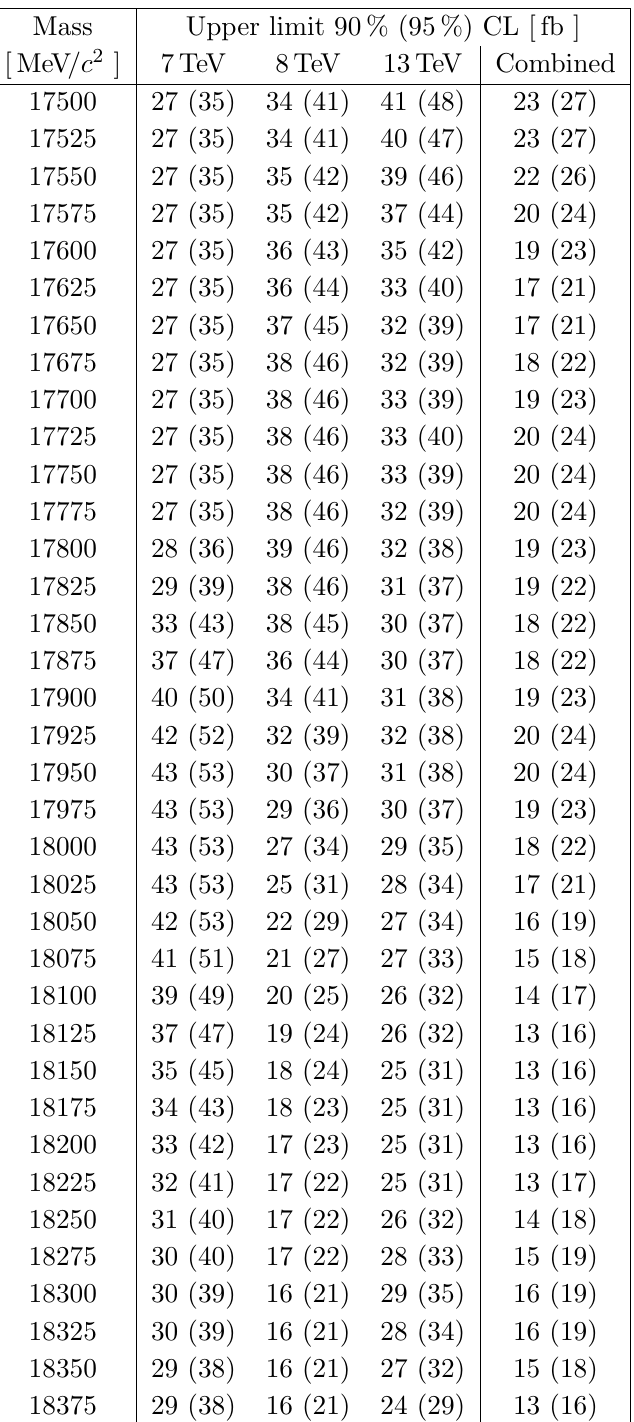
Table 1 . Upper limits on (cid:27) ( pp ! X ) (cid:2) B ( X ! (cid:7) (1 S ) (cid:22) + (cid:22) (cid:0) ) (cid:2) B ( (cid:7) (1 S ) ! (cid:22) + (cid:22) (cid:0) ) for di(cid:11)erent X mass hypotheses in the range [17 : 5 ; 18 : 4] GeV =c 2 .